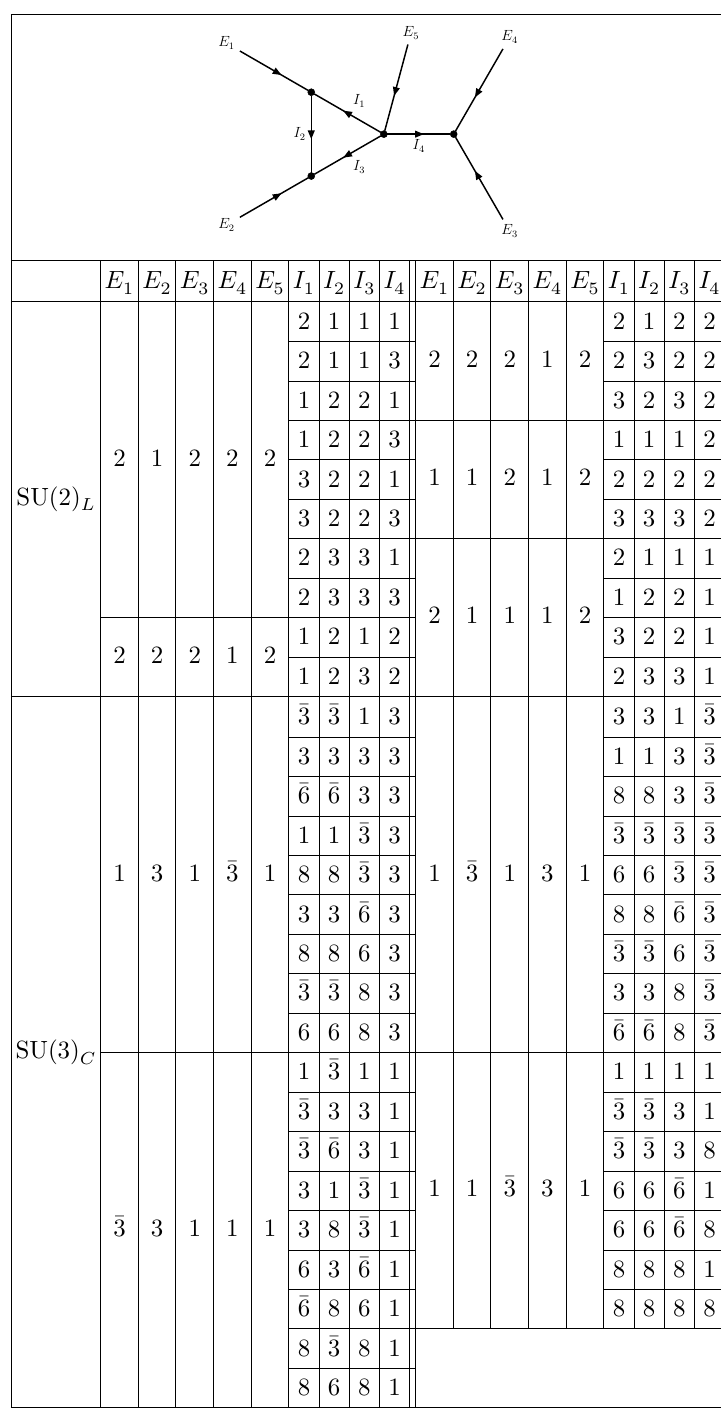
Table 6 . The independent SU(2) and SU(3) quantum number assignments for the topology L C NL-1-1, where E and I denote the external fields and internal fields respectively. Other assignments i i are related to these in the table through permutations of external and internal